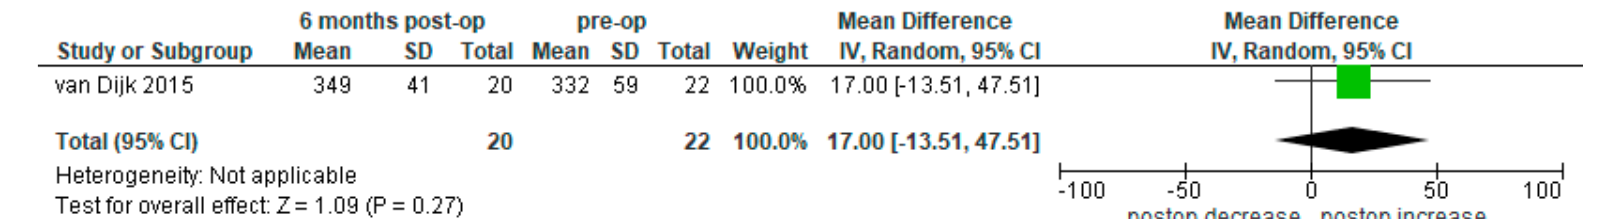
Figure A8. Di ff erence in best contact lens-corrected visual acuity across 2 studies [31,36].